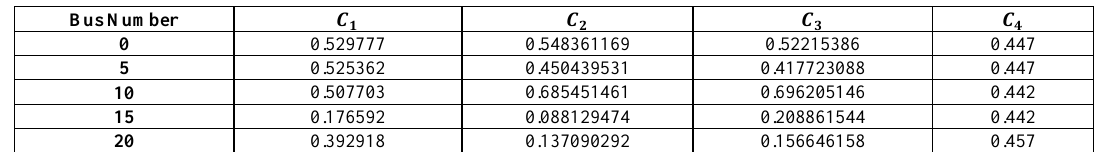
Table 3. Normalized decision